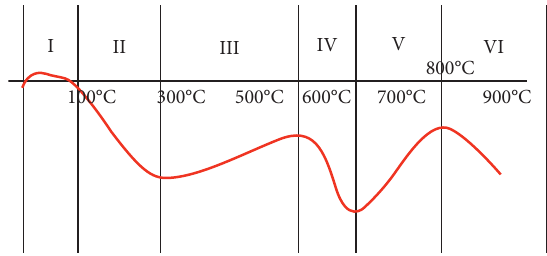
Figure 3: Thermal expansion process of the